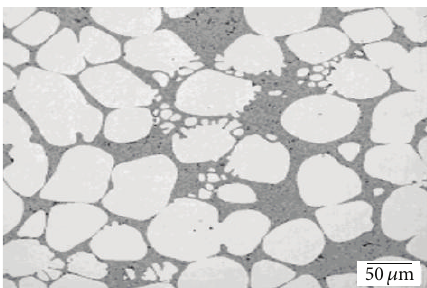
Figure 19: Microstructure of A356 aluminum obtained by the SEED method